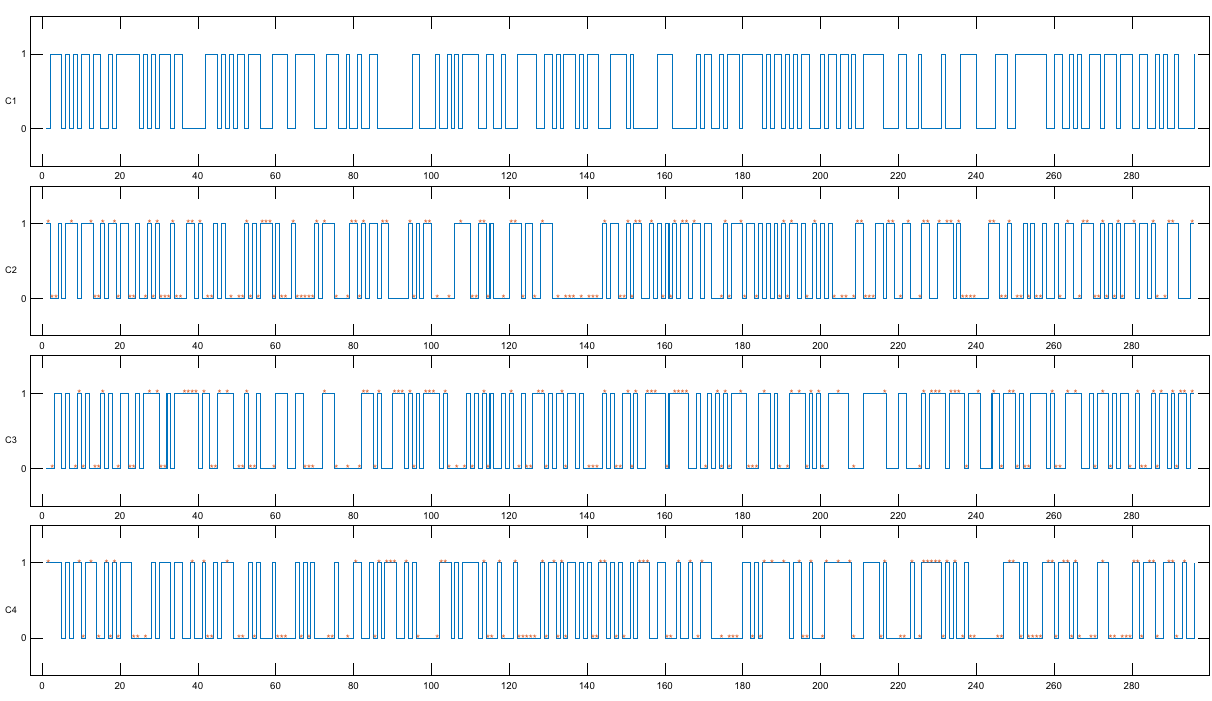
Figure 1. Hash values in the binary format generated by QHFL-296. The symbol * represents a different bit H M between H M 2 and H M 2 4 . −